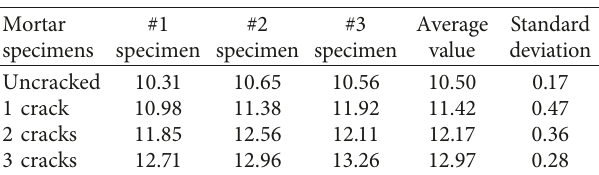
Figure 4: Chloride penetration area in the mortar specimens. (a) Uncracked mortar specimen. (b) Mortar specimen with 3 cracks. Table 2: Chloride penetration depth ( X ) in the mortar specimens (mm).